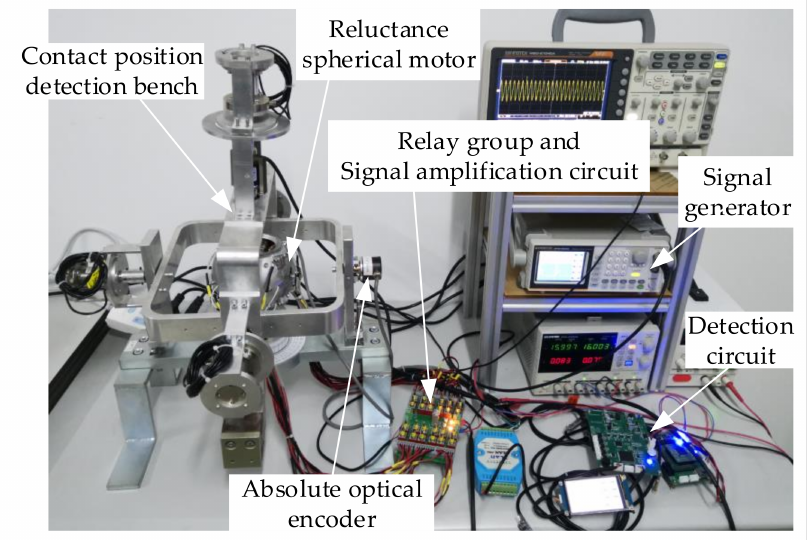
Figure 3. Mutual inductance voltage experimental